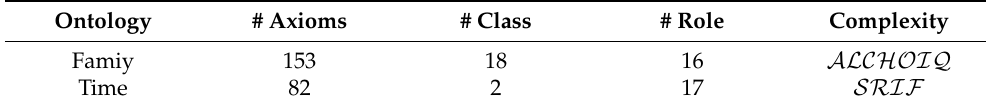
Table 1. Statistics of the Ontologies Used in the Experiments.